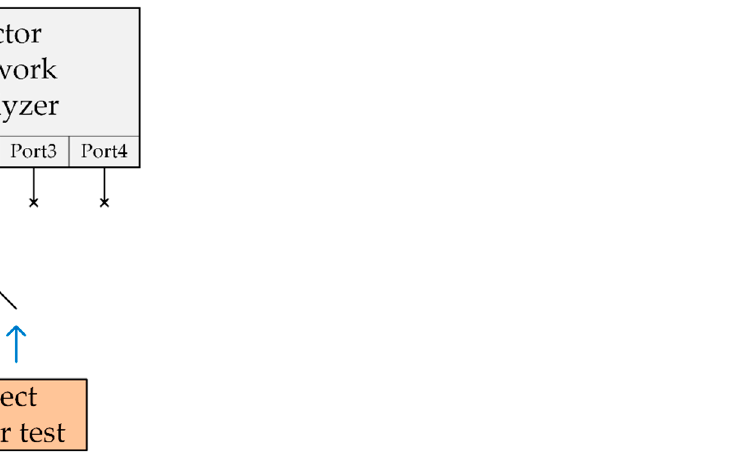
Figure 1. General diagram of microwave measurement technique based on reflection coefficient ap- proach.